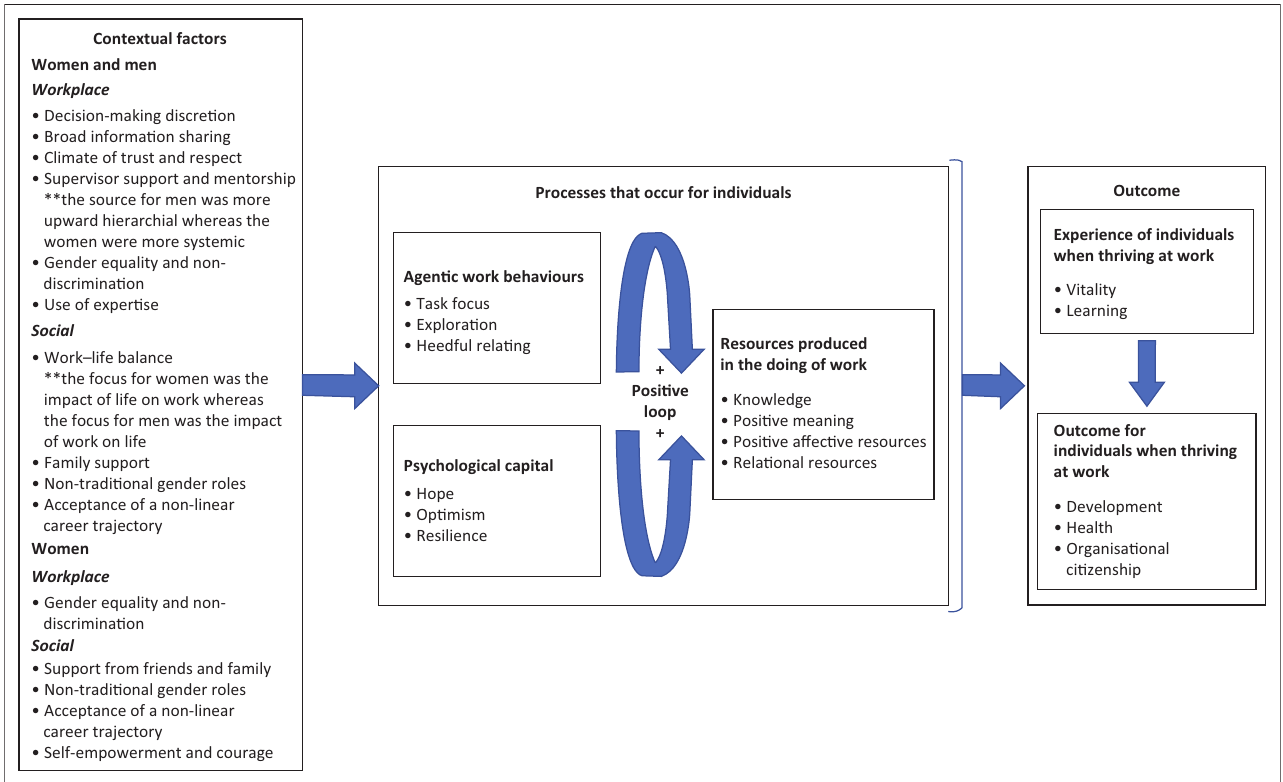
FIGURE 2: Framework of empirically derived elements contributing to women thriving in the